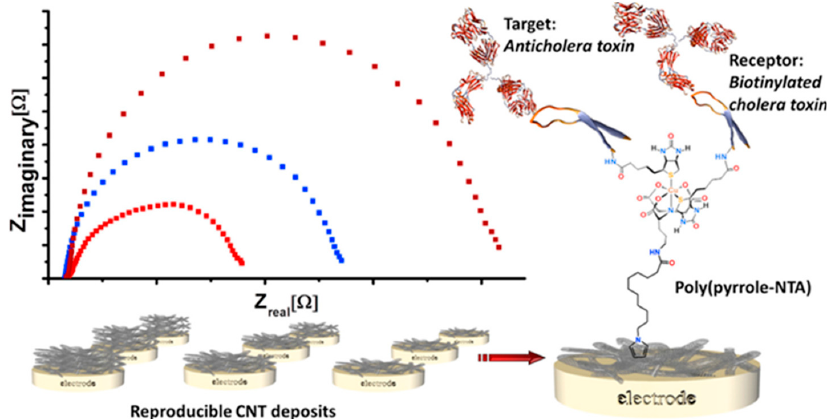
Figure 5. Scheme of an EIS-based immunosensor for anti-cholera toxin antibodies prepared by coordinative binding of the biotinylated cholera toxin on poly(pyrrole-NTA)/Cu 2+ electropolymerized at a MWCNTs/GCE, and Nyquist plots obtained by measurement of [Fe(CN) 6 ] 4 − /3 − . Reprinted from [84] with permission.